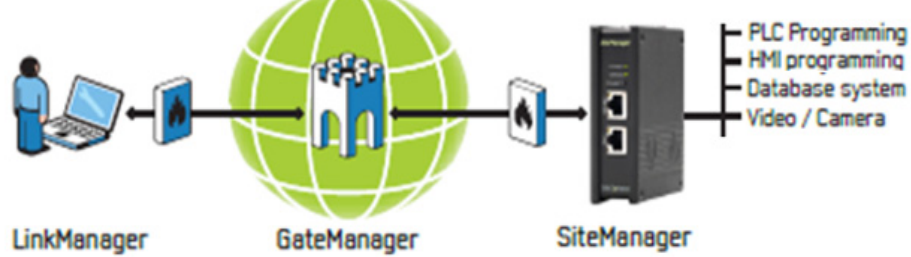
Figure 19. The global telecommunication elements for the realization of the remote control function.